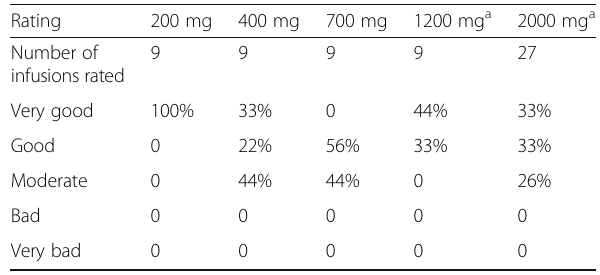
Table 2 Treatment with Helixor® P and dose limiting toxicity (DLT) Dose in mg